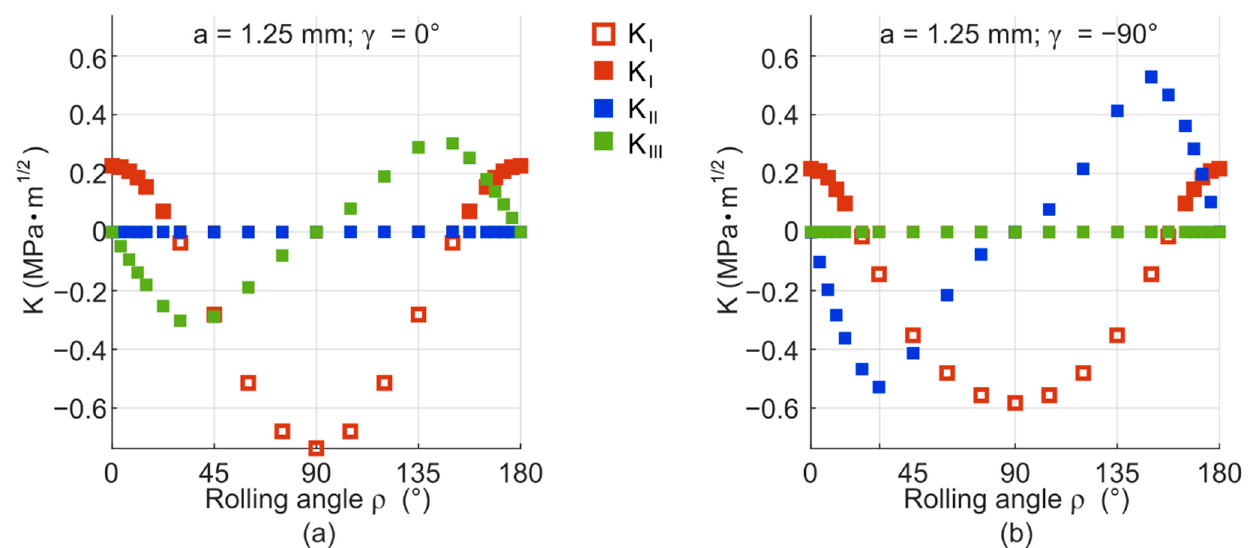
Figure A9. Course of stress intensity factors during rotation in the cylinder D × L = 6 × 6 mm 2 , load F = 350 N, a = 1.25 mm, position on the crack front; ( a ) γ = 0°; ( b ) γ = − 90°. Model including friction.